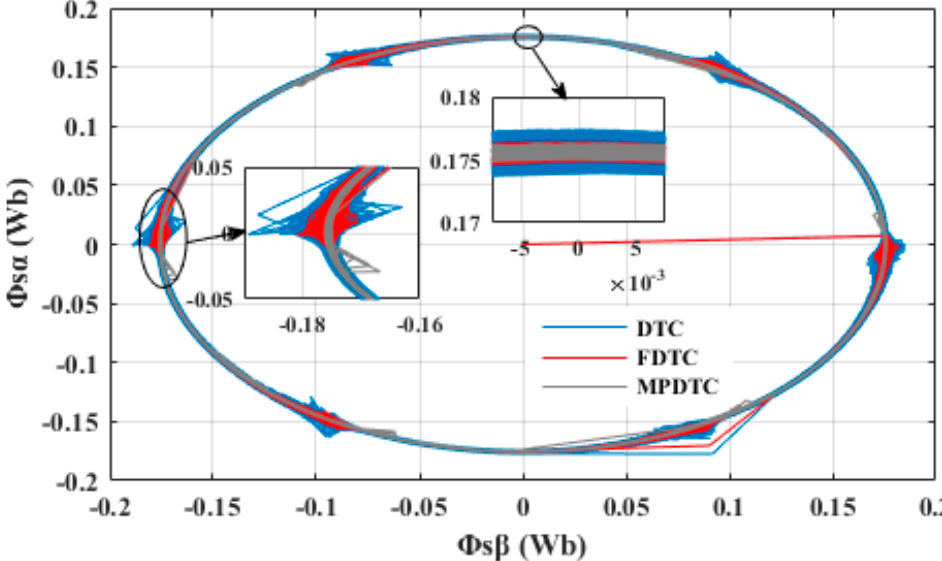
Figure 17. Stator fl ux loci of the PMSM under di ff erent control techniques with NYCC driving cycle.